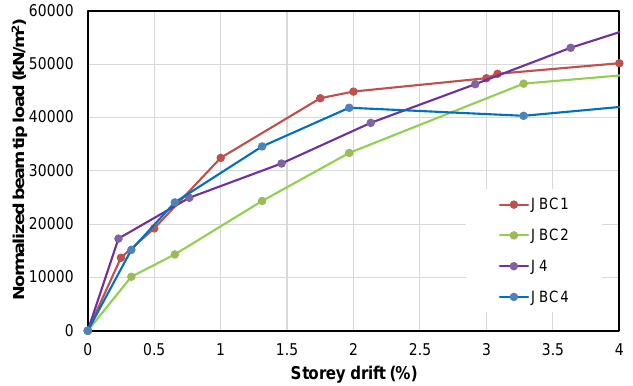
Figure 4. Beam tip load versus story drift envelope of the tested specimens.